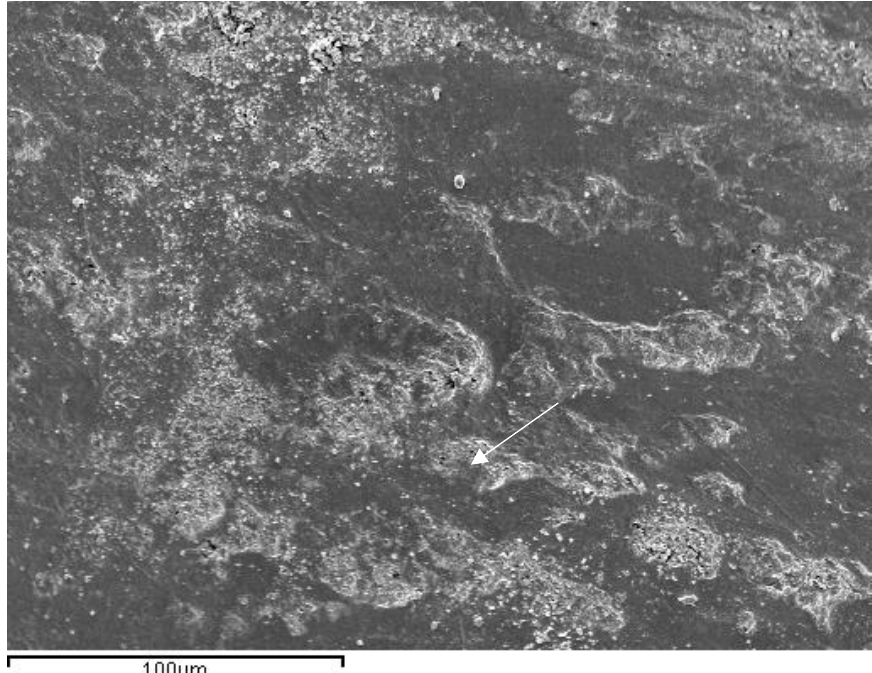
Figure 8. Representative image of enamel of a Group 2 sample after polishing with 30-blade carbide bur at a high speed (arrow points at the most evident indentation of the bur on the enamel surface).